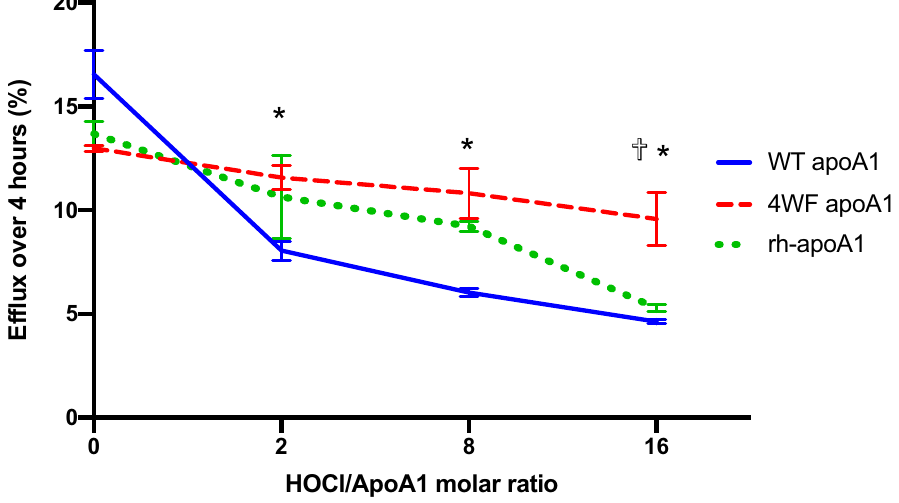
Figure 2. ApoA1(4WF)-, but not apoA1(WT)-mediated efflux following transduction with the respective AAV2 vectors demonstrates oxidative resistance. Cell culture media conditioned by HEK 293 cells transduced with AAV2-apoA1(WT), AAV2-apoA1(4WF), both containing 10 µg/ml of AAV2-encoded apoA1 variants, and the conditioned media from the non-transduced HEK-293 cells supplemented with 10 µg/ml of recombinant human apoA1 (rhapoA1) were incubated with increasing concentrations of HOCl. Cholesterol efflux assays were then performed on 3 H-cholesterol-loaded Raw 264.7 cells incubated with differently oxidized conditioned media from HEK-293 cells for 4 h. *P < 0.05 4WF vs WT. ✞ P < 0.05 4WF vs